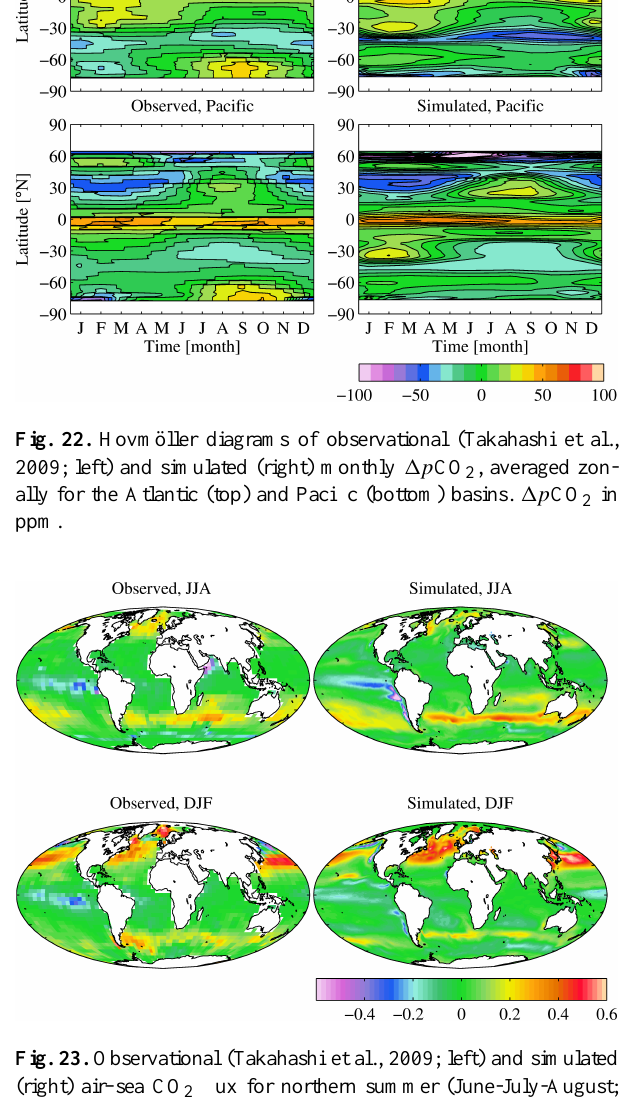
Fig. 23. Observational (Takahashi et al., 2009; left) and simulated Fig. 21. Observational (Takahashi et al., 2009; left ) and simulated ( right ) air–sea CO 2 flux for northern summer (June–July–August; top ) and northern winter (December–January–February; bottom ). Air–sea CO 2 flux in mol C (right) air–sea CO 2 flux for northern summer (June-July-August; m − 2 month − 1 . top) and northern winter (December-January-February; bottom). Air–sea CO 2 flux in molCm − 2 month − 1